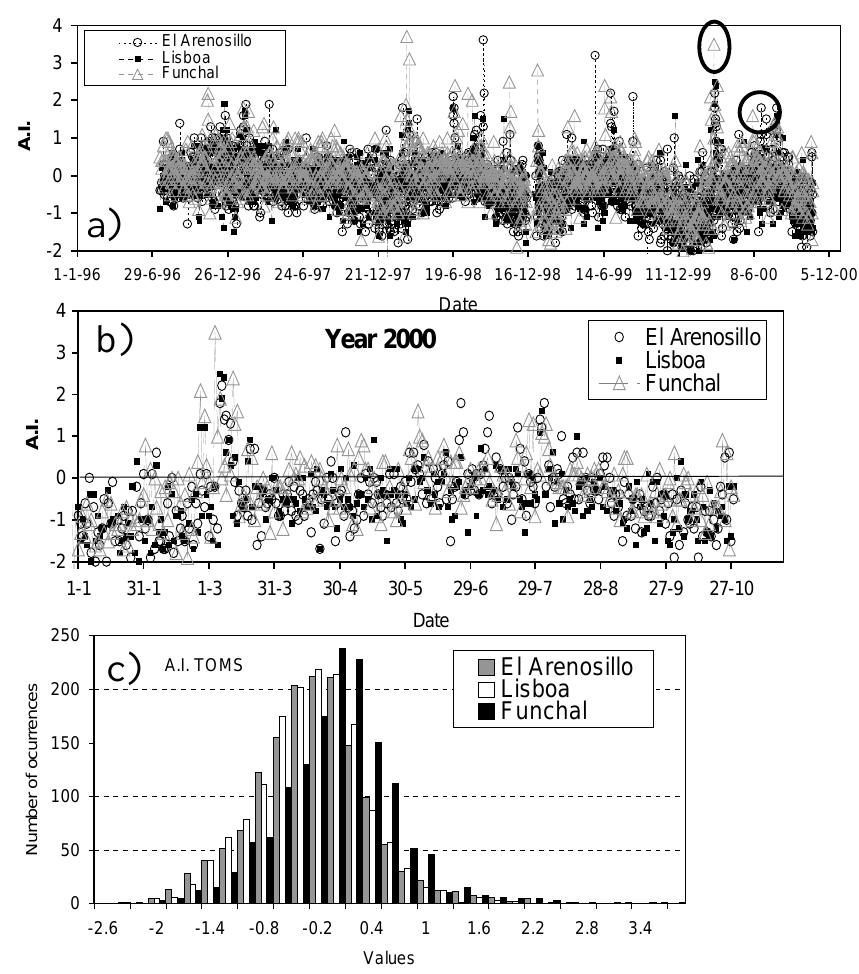
Fig. 2. (a) Evolution of TOMS’ Aerosol Index from July 1995 to December 2000 for the three stations: Funchal, Lisboa and El Arenosillo. (b) The same for year 2000. (c) Frequency distribution function of AI values over the three